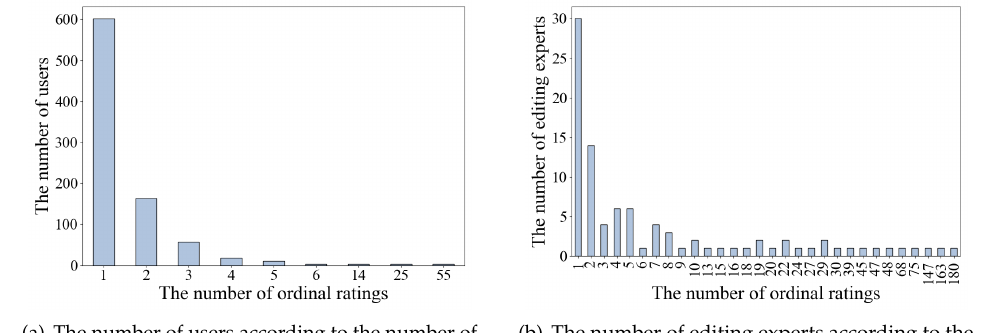
Figure 5. Visualization of the ordinal ratings utilized in the